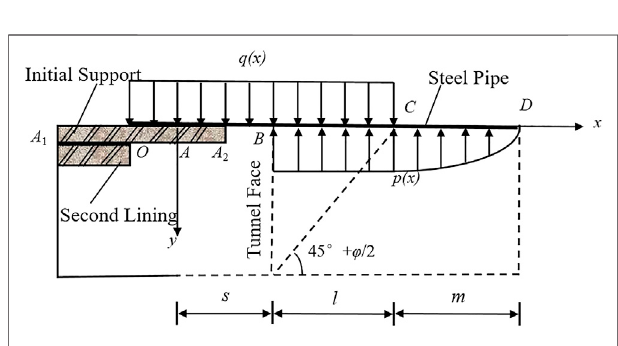
FIGURE 4 | Analysis model of the mechanical behavior of the